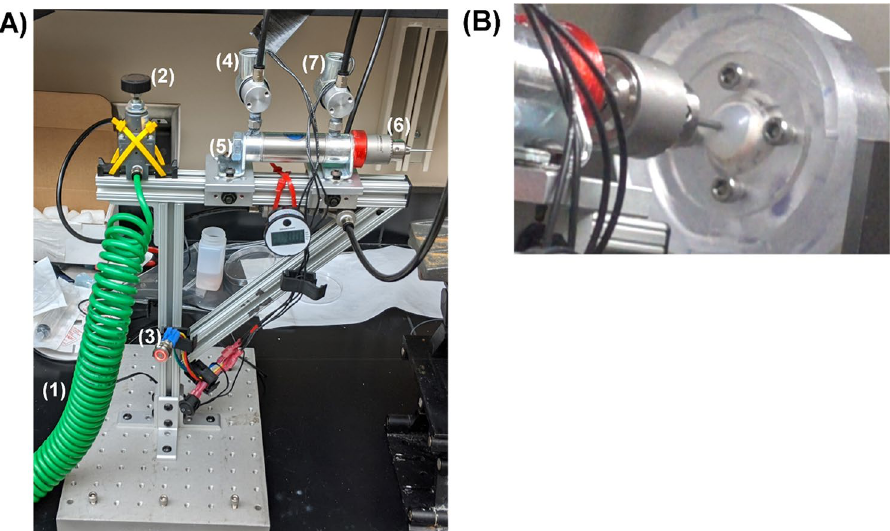
Figure 10. The pneumatic open globe injury device. ( A ) Overview of the device where (1) compressed air is delivered to a (2) pressure regulator set at 50 psi. After the device is (3) fired, the first (4) solenoid valve opens which drives the (5) linear actuator forward causing the (6) drill chuck and puncture object to create an injury in the ASOC setup. Afterwards, the (3) button is released which causes air to be redirected to the second (7) solenoid valve and retract the linear actuator and puncture device from the eye. ( B ) Image of the ASOC setup undergoing OG Injury induction.